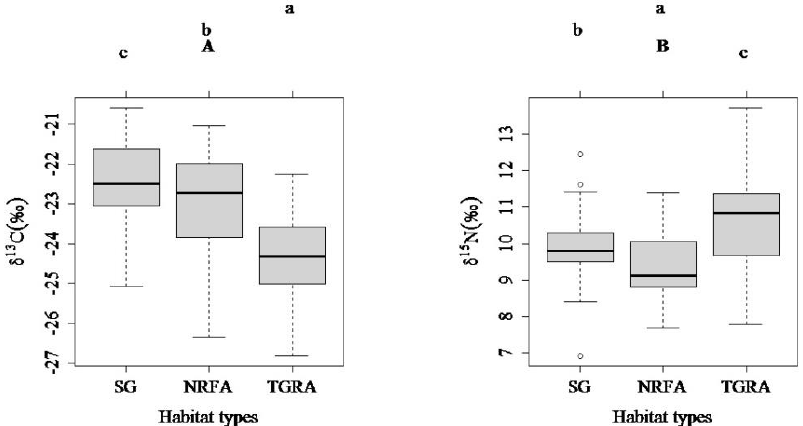
Figure 2. Comparisons of δ 13 C ( A ) and δ 15 N ( B ) values among three habitat types using Tukey’s test (different lowercase letters indicate significant differences; SG: spawning ground; NRFA: the natural riverine feeding and nursery area; TGRA: The Three Gorges Reservoir area; boxes show interquartile ranges, the horizontal bar indicates the median value, and whiskers reflect 1.5 × the interquartile range). No significant difference was detected for δ 13 C values between the two ontogenetic stages, while strong evidence of δ 15 N difference between the two ontogenetic stages was detected (Figure 3; t test, δ 13 C: t = 1.50, p = 0.14; δ 15 N: t = − 2.52, p <